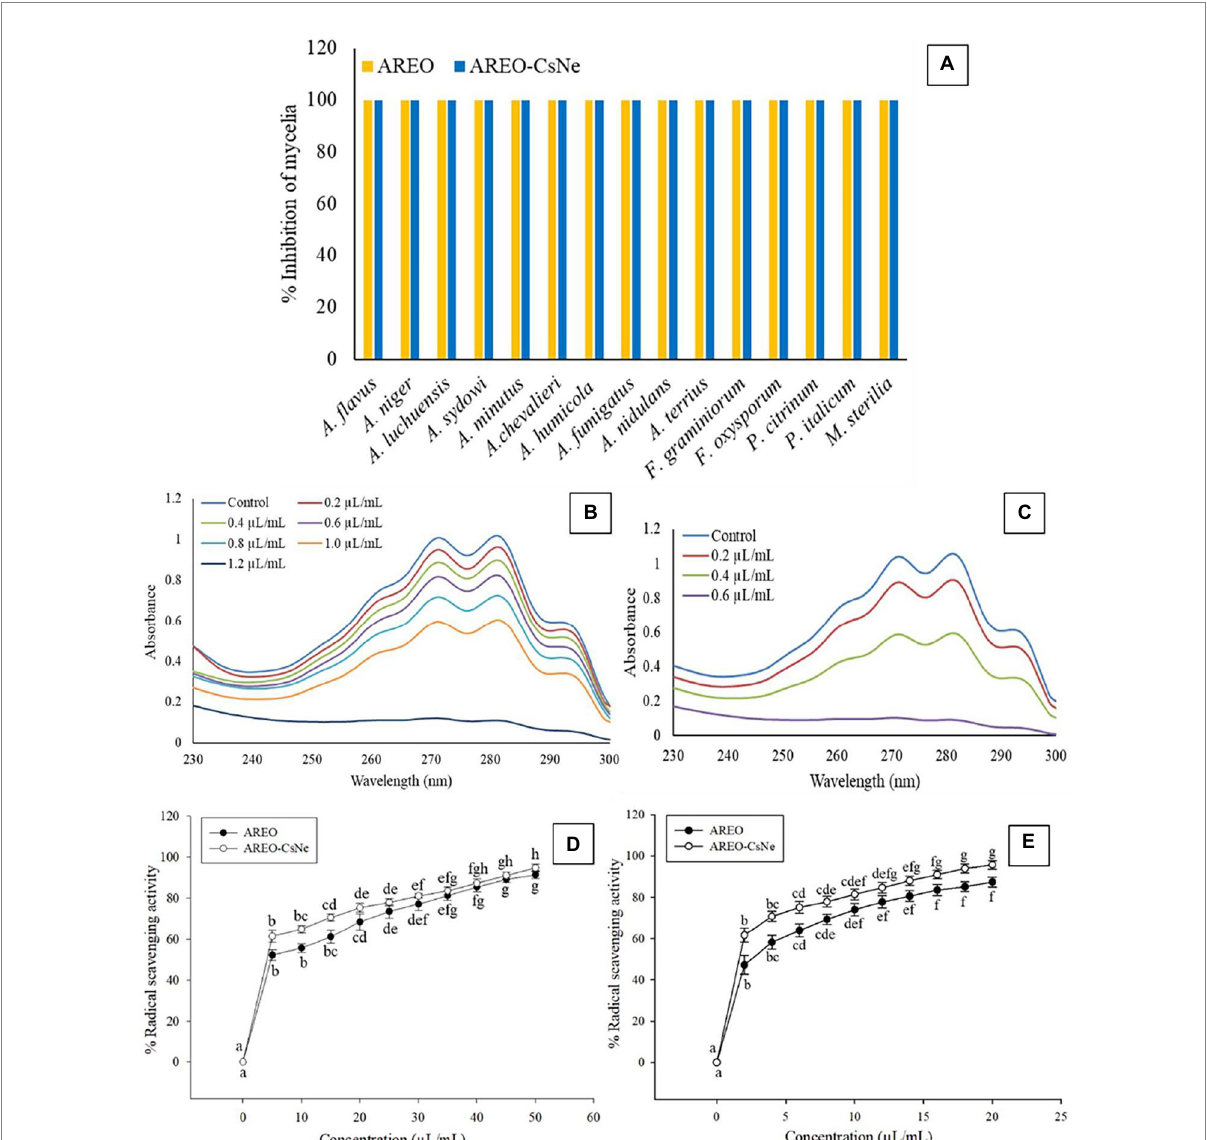
FIGURE 2 Fungitoxic spectrum of AREO and AREO-CsNe against food contaminating fungi (A) , effect of AREO and AREO-CsNe on membrane ergosterol level of AFLHPSi-1 (B,C) , antioxidant activity of AREO and AREO-CsNe by DPPH (D) and ABTS (E)